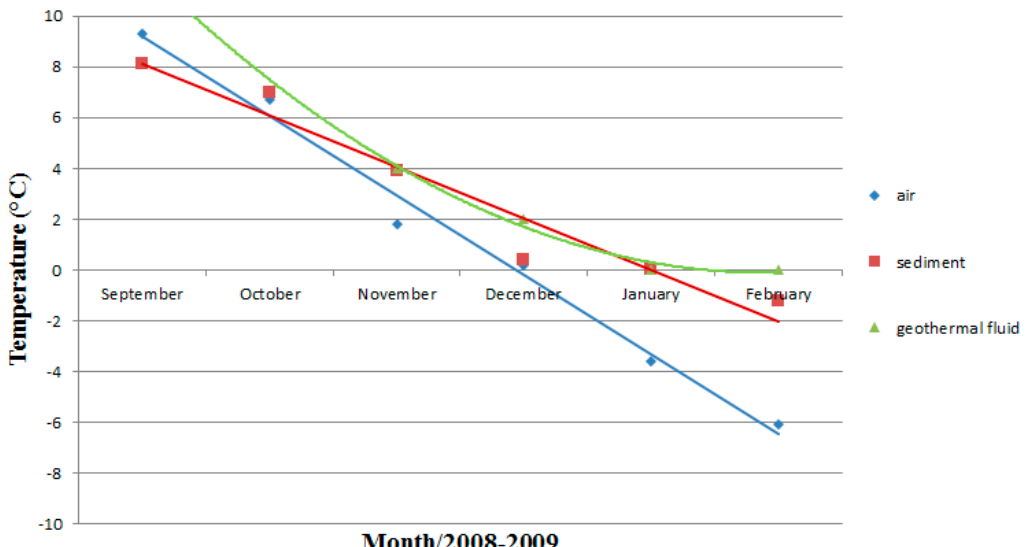
Figure 3. The relationship between the air, sediment and geothermal fluid temperatures in the low energy network of Suvilahti, Vaasa, 2008–2009. The lines are drawn to visualize and approximate relationship between measurements points.